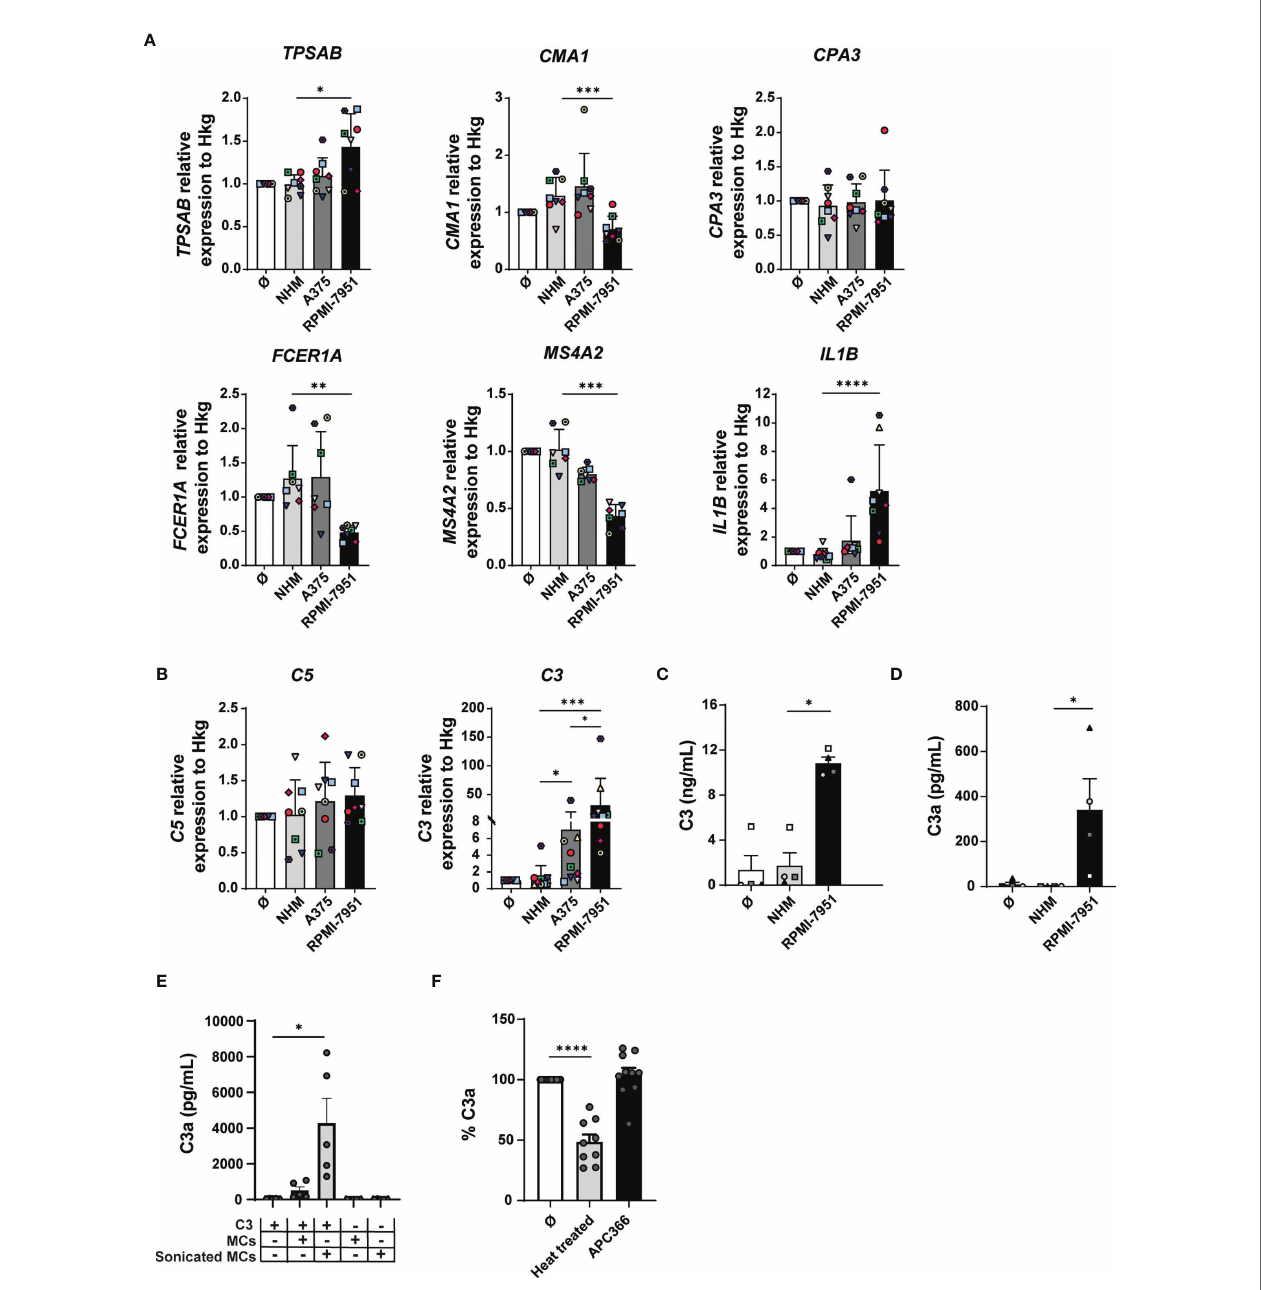
FIGURE 5 | Melanoma cell culture supernatants reproduce some of the transcriptional changes found in MAMCs and induce C3 expression in MCs. MCs were incubated for 48 h with melanoma cell culture supernatants (A375 and RPMI-7951), melanocyte cell culture supernatant (NHM), or medium alone (Ø). (A) mRNA levels of tryptase ( TPSAB ), chymase ( CMA1 ), carboxypeptidase A3 ( CPA3 ), Fc e RI a ( FCER1A ), MS4A2 ( MS4A2 ), and IL-1 b ( IL1B ) and (B) mean relative transcription levels of C3 and C5 were measured by real-time RT-PCR and normalized by the mean of three housekeeping genes ( PPIA , 18S , and H3-3B ). Data were normalized to medium-treated control samples (Ø). Data represent the mean ± SEM of at least seven independent experiments ( n = 7 – 8). (C) Quanti fi cation of C3 in MC pellets was performed by ELISA. (D) C3a was measured by CBA. Results are shown as mean ± SEM of at least four independent experiments. One-way ANOVA statistical test was used: * p < 0.05, ** p < 0.01, *** p < 0.001, **** p < 0.0001. (E) C3 was incubated for 20 min with MCs in which the cellular membrane was disrupted by sonication (sonicated MCs) or with untreated (membrane-intact) cells (MCs). Concentration of generated C3a was then measured by CBA. Results are shown as mean ± SEM of at least fi ve independent experiments. One-way ANOVA statistical test was used; * p < 0.05, n = 5. In (F) , C3 was incubated with sonicated MCs used here as control (Ø), heat-treated MCs (2 h at 56°C) ( n = 9). To inhibit MC tryptase activity, 100 m M of the tryptase-speci fi c inhibitor APC366 was added 30 min before the assay (APC366) ( n = 10). Data are represented as the mean percentage of C3a in the sonicated MCs control (Ø) ± SEM of at least nine independent experiments. One-way ANOVA statistical test was used; **** p <